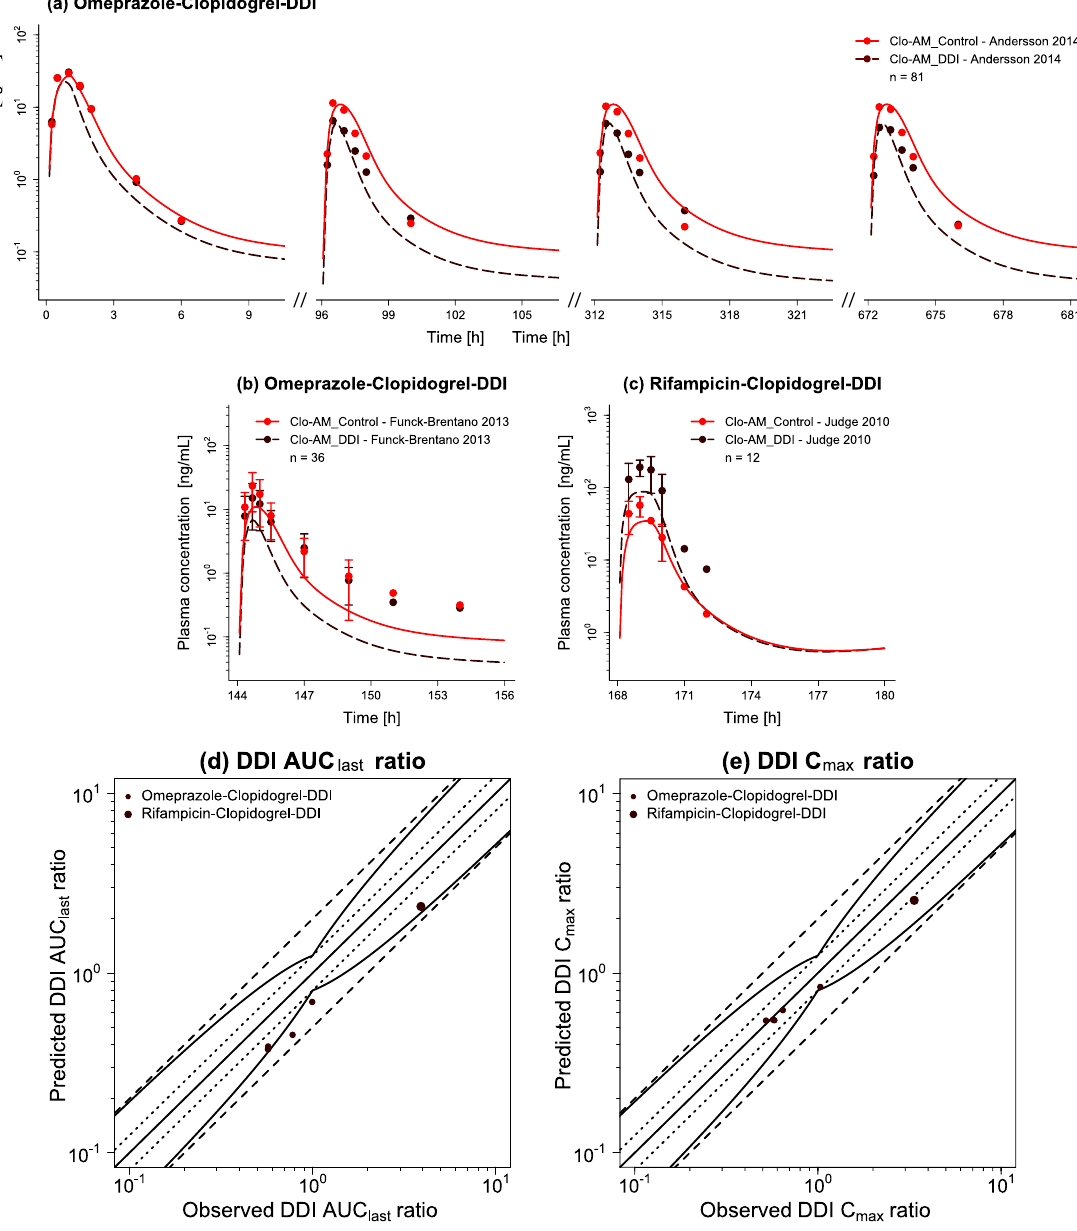
Figure 6. Drug–drug interaction network evaluation with clopidogrel as victim. Presented are predicted plasma concentration-time profiles of Clo-AM with (DDI) and without (Control) intake of the respective perpetrator drug (( a , b ) omeprazole, ( c ) rifampicin), alongside corresponding observed data [25–27]. Dashed (DDI) and solid (Control) lines represent the model predictions, while corre- sponding observed data are shown as symbols ( ± standard deviation, if available). Predicted versus observed ( d ) DDI AUC last and ( e ) DDI C max ratios are shown with the solid line representing the line of identity, dotted lines indicating 1.25-fold, and dashed lines 2-fold deviation from the respective observed value, along with the curved lines marking the prediction success limits proposed by Guest et al. [75] (including 20% variability to account for uncertainties in observed ratios). Detailed information on all DDI studies as well as individual DDI AUC last and DDI C max ratios are provided in Tables S10 and S19 of the Supplementary Materials. AUC last : area under the plasma concentration-time curve determined between first and last concentration measurements, Clo-AM: clopidogrel thiol H4, C max : maximum plasma concentration, DDI: drug–drug interaction, n: number of